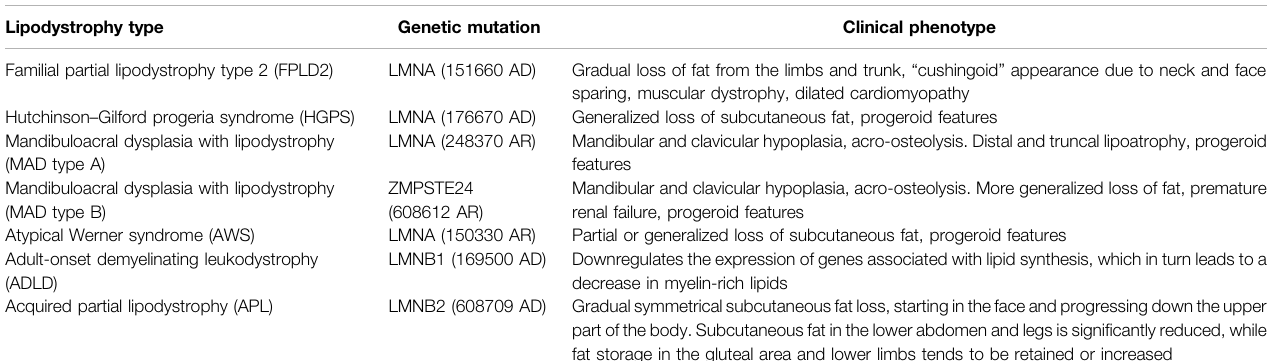
TABLE 1 | Nuclear lamina-related diseases about genetic lipodystrophy